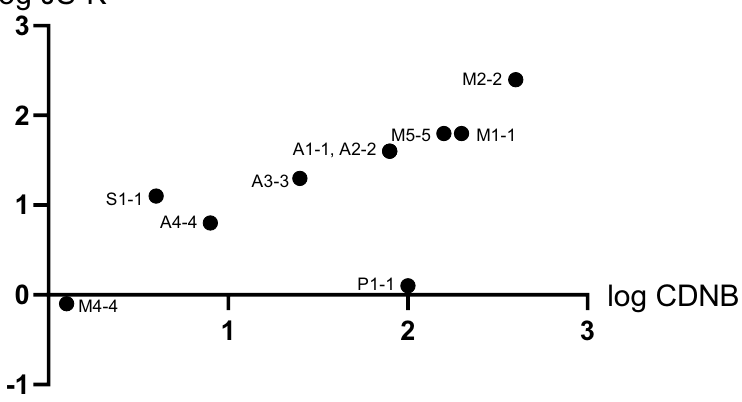
Figure 4. Correlation between specific activities of human GSTs with JS-K and CDNB as substrates. The data point for GST P1-1, with low JS-K and high CDNB activity, is a prominent outlier not included in the correlation analysis, which yields a slope of 1.0 and R 2 =